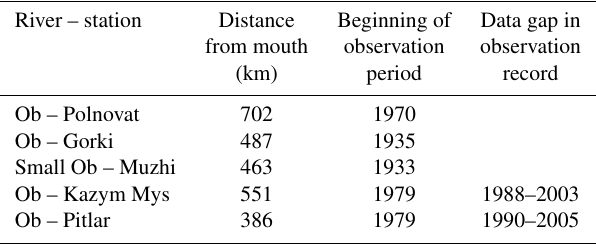
Table 1. Gauging stations in the lower reaches of the Ob River.